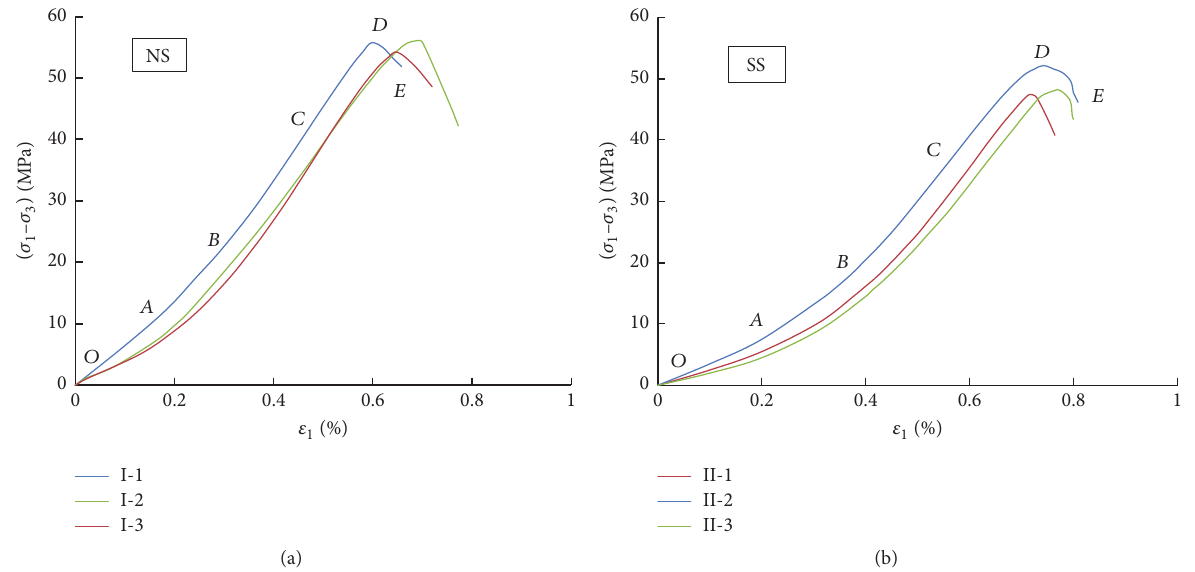
Figure 4: The stress-strain curves of uniaxial compression tests under natural and saturated states. Note: NS refers to “under the natural state” and SS refers to “under the saturated state.”